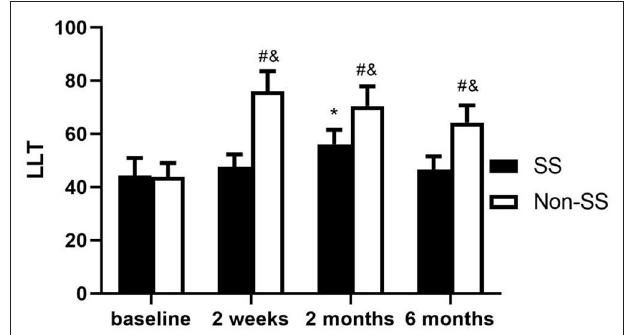
FIGURE 3 | Changes of LLT after punctal plugs insertion. LLT had no difference between the two groups at baseline ( P > 0.05) and it was significantly larger in the non-SS group than in the SS group at every visit after the treatment (all p < 0.05). Compared with the baseline, the increase of LLT in SS group was statistically significant only at 2 months ( p < 0.05) and in non-SS patients it was greater than the baseline at every visit ( p < 0.01). ( & p < 0.05 in SS vs. non-ss, * p < 0.05 in SS vs. baseline, # p < 0.05 in non-SS vs. baseline).